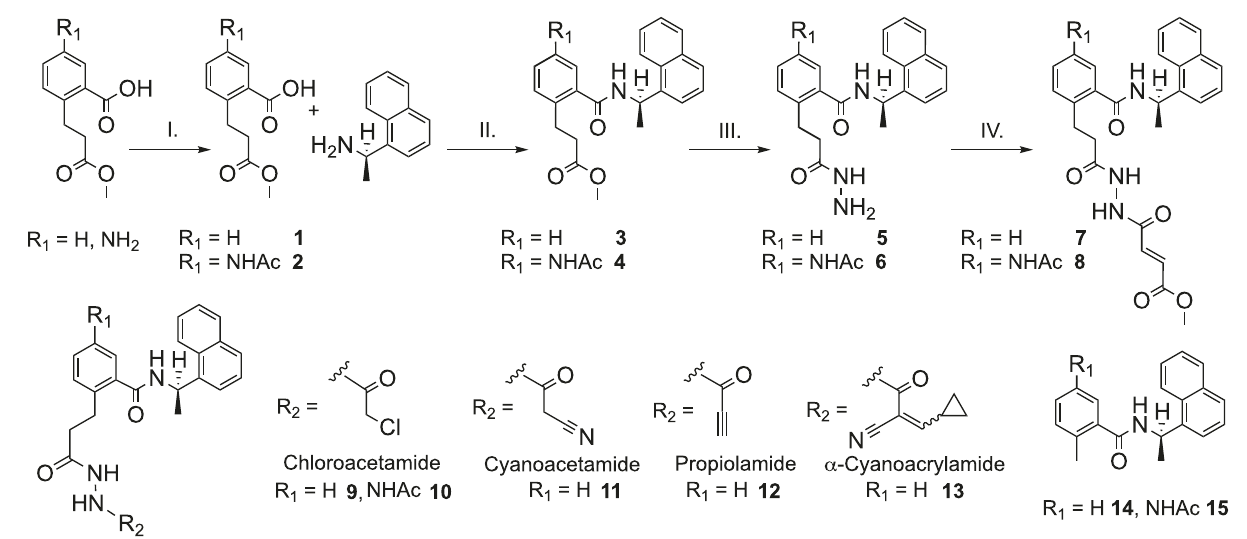
Fig. 4 | Synthesis of compounds 2-15. Reaction conditions with yields in par- entheses: I. Ac 2 O, AcOH, DCM, 55%; II. HATU, DIPEA, DCM ( 3 , 83%; 4 , 91%); III. N 2 H 4 • H 2 O, EtOH ( 5 and 6 , 97%); IV. methyl ( E )-4-chloro-4-oxobut-2-enoate, DIPEA, DCM for 7 (56%), and K 2 CO 3 , DMF for 8 (34%). Compounds 9 (50%), 10 (37%), 11